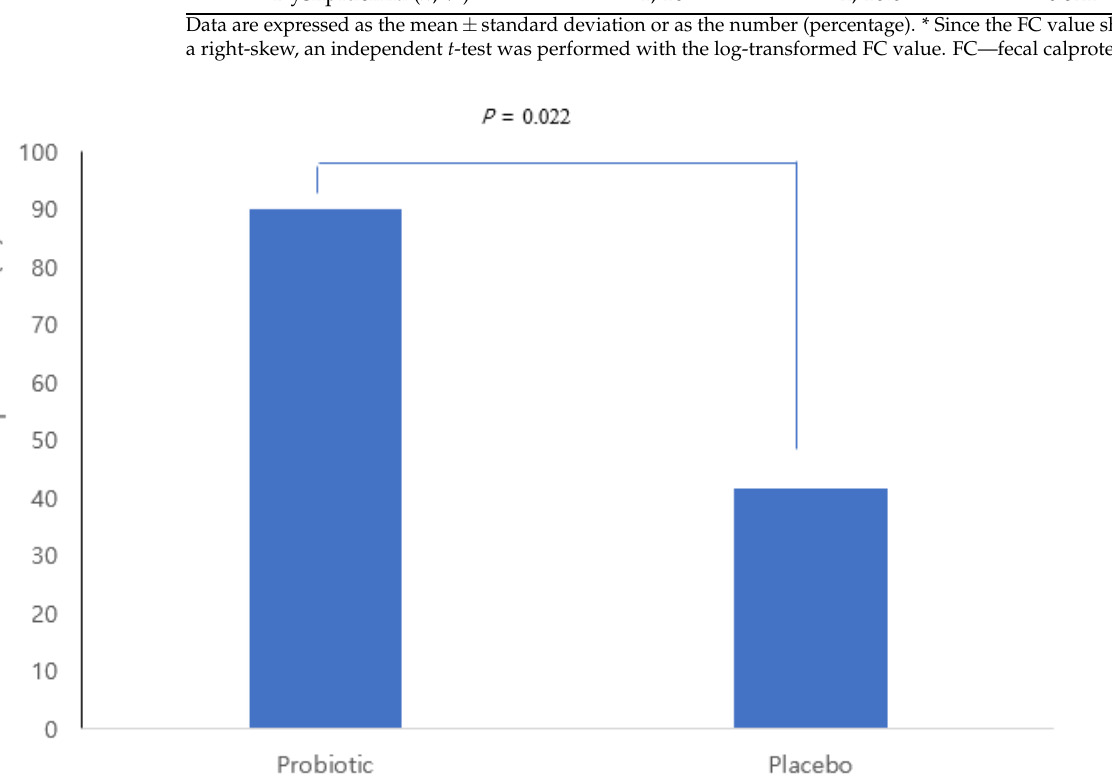
Table 1. Baseline characteristics of the study subjects.